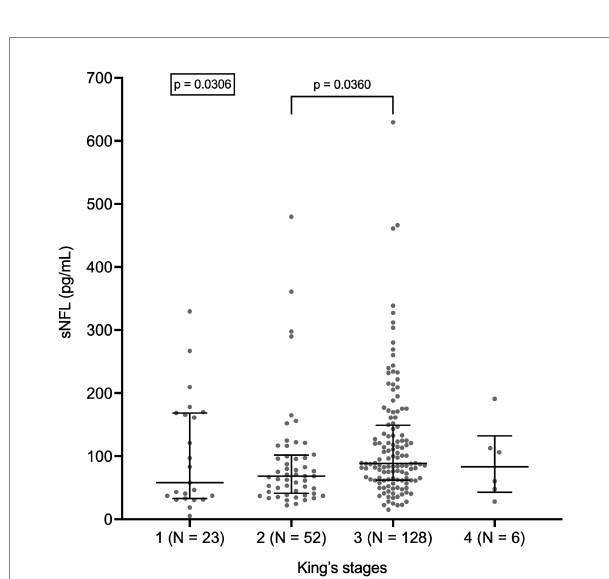
FIGURE 4 Serum NFL levels in different King’s stages. Wide horizontal bars represent median values, narrower horizontal bars represent first and third quartiles. NFL, neurofilament light chain; sNFL, serum neurofilament light chain.